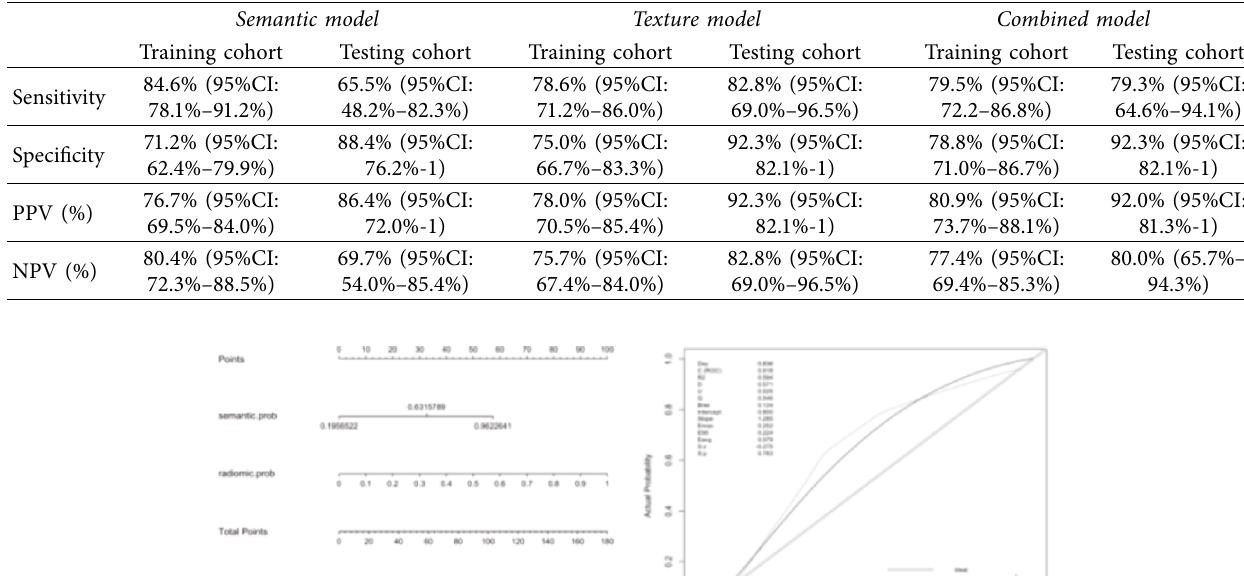
Table 2: Detailed diagnostic performance of the three models in the training and testing